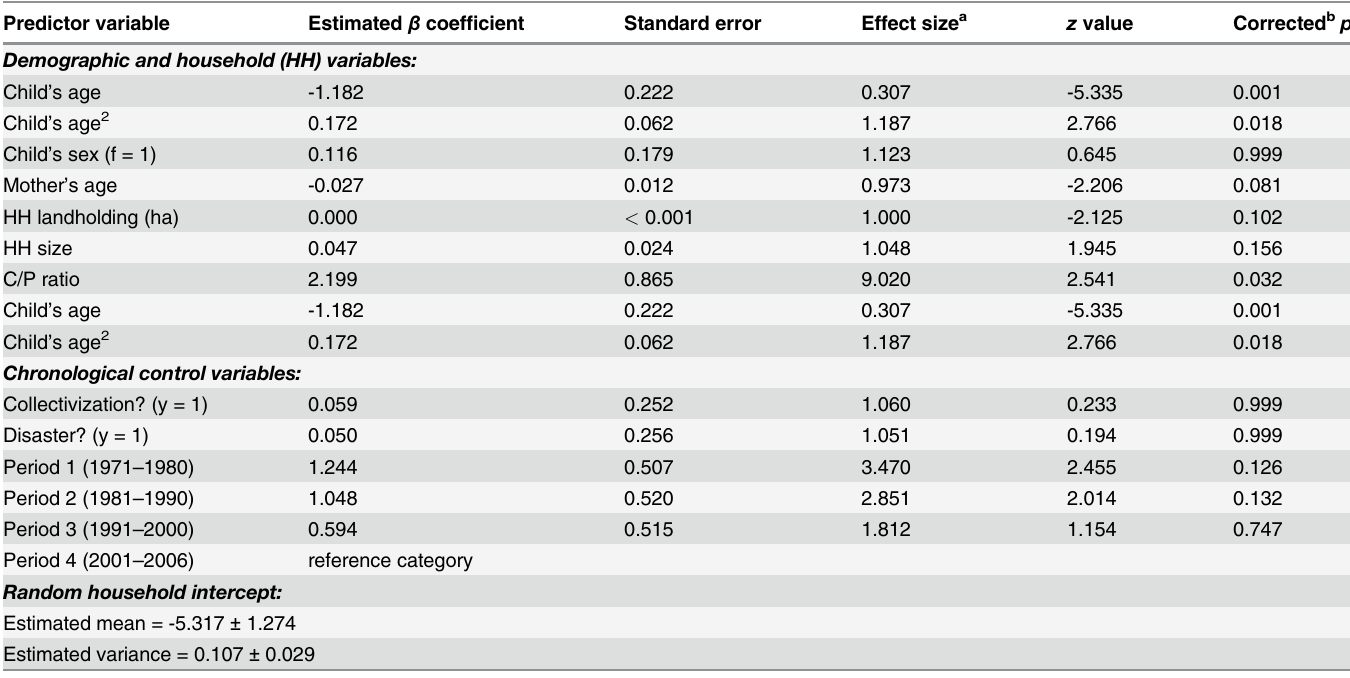
Table 3. Mixed-effect logit hazard model with random household-level intercept, early childhood mortality (ages < 5 years), Na Savang Village, northern Laos 1971 – 2006. Predictor